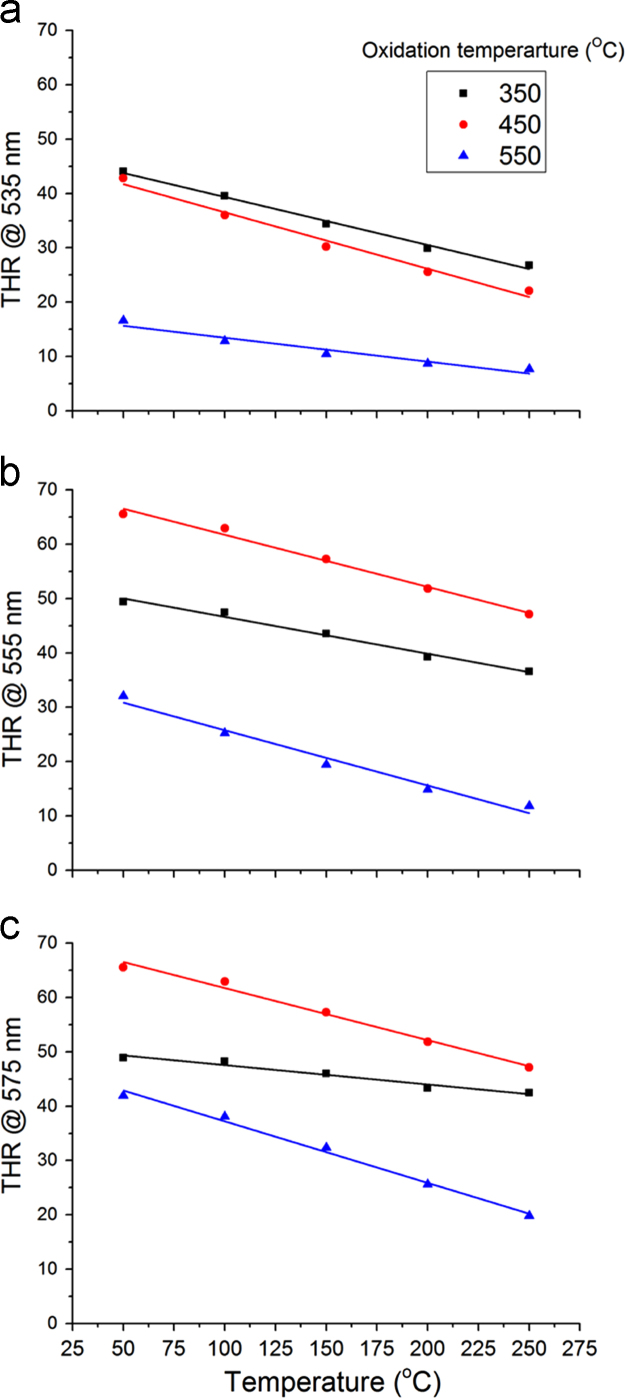
Plot of THR at (a) 535 nm, (b) 555 nm and (c) 575 nm versus temperature for V2O5 coatings annealed at 350 °C, 450 °C and 550 °C respectively.